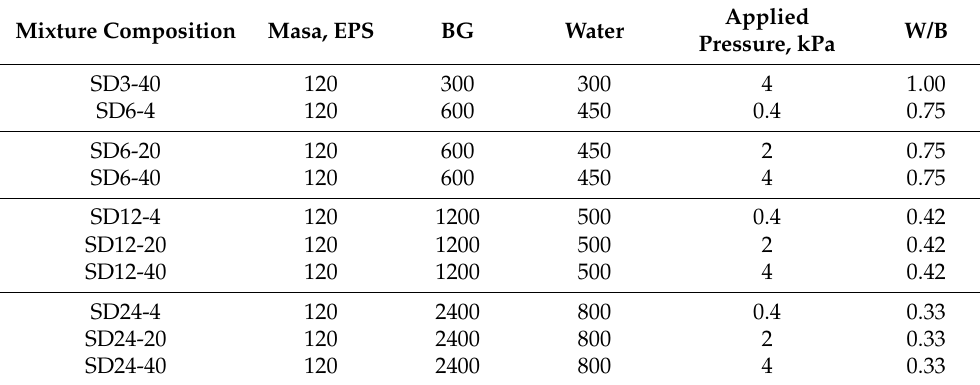
Table 4. Compositions of EPS and gypsum samples for curing under pressure method. Mixture